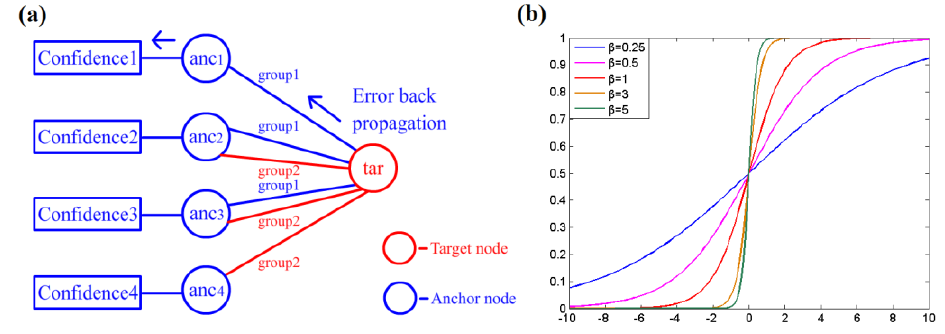
Figure 4. ( a ) Illustration of the back propagation learning procedure; ( b ) Curve of the back propagation function f(x) .